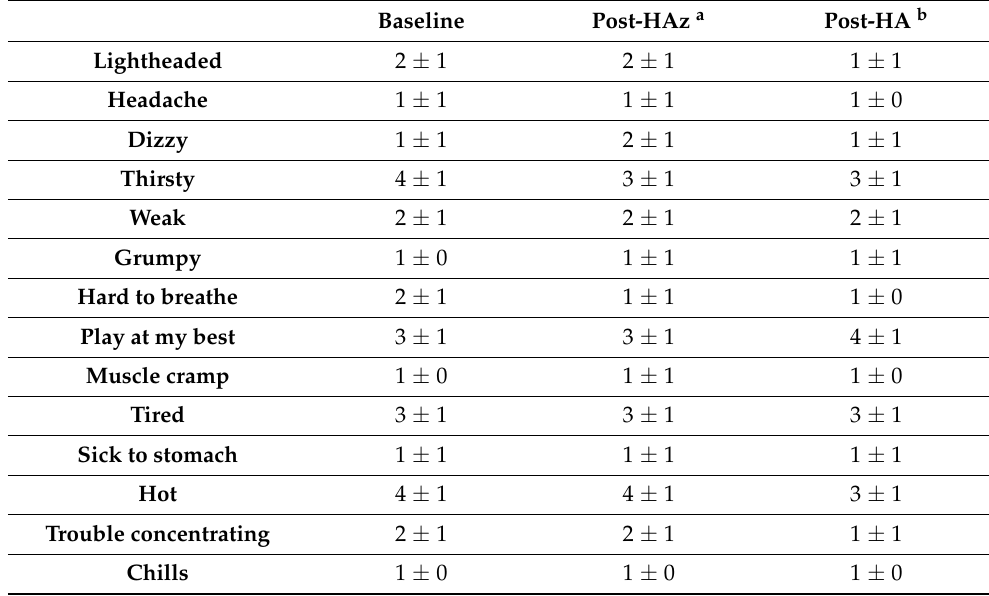
Table 2. Means and standard deviations (Ms ± SDs) of post-trial Environmental Symptoms Ques- tionnaire (ESQ) total scores for maximal heat training group (HT MAX ), minimum heat training group (HT MIN ), and the control group (HT CON ) after heat acclimation (post-HA), at week 4 of HT (post- HT4), and at week 8 of HT (post-HT8). Groups were split post-HA prior to beginning HT (post-HT4 and post-HT8). Group summaries were extrapolated from post-HA to help track environmental symptom changes that occurred over HT. Post-HA (M ± SD)